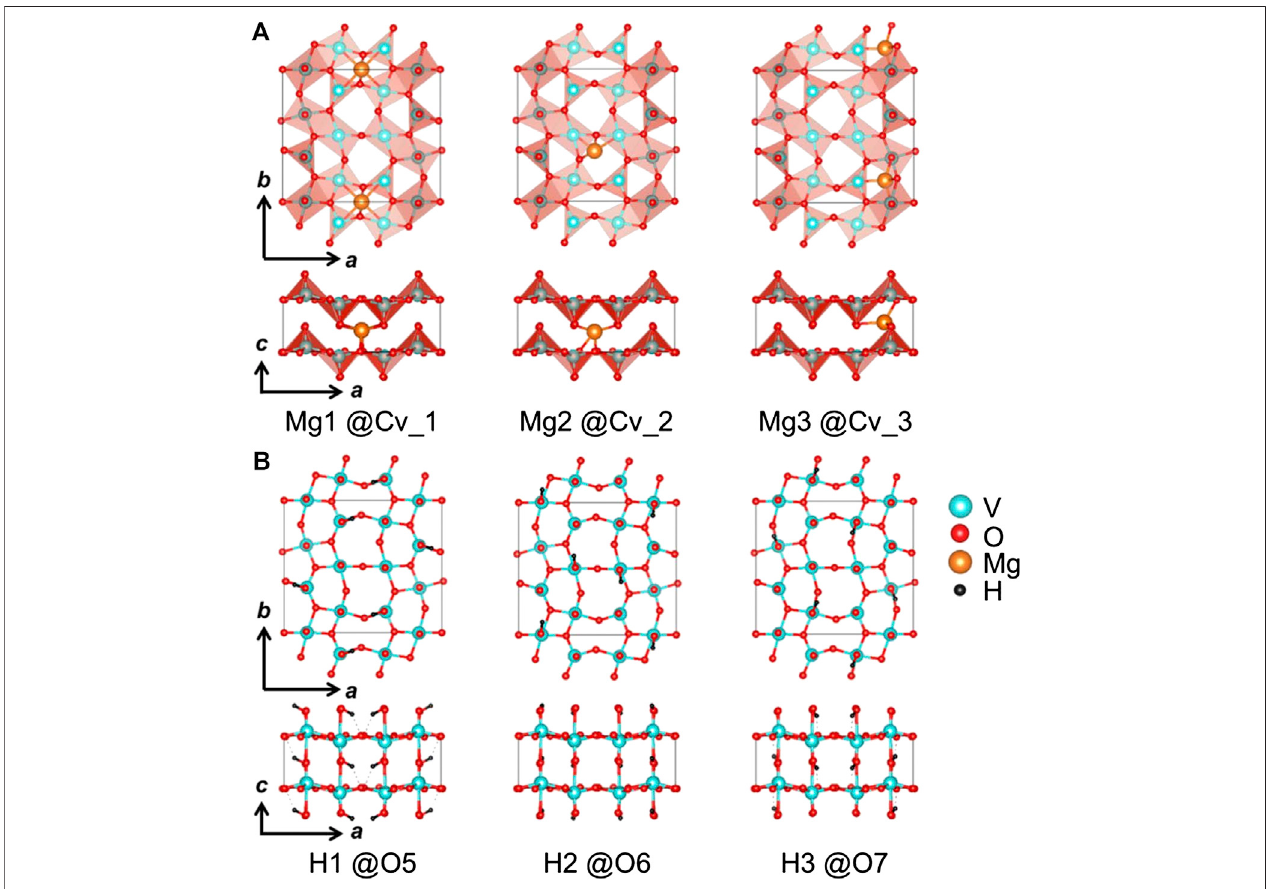
FIGURE 3 | Optimized positions of magnesium and proton ions suggested by DFT calculations for Mg 0.17 H x V 2 O 5 ( x (cid:2) 1): (A) Mg ions in three cavity sites (Cv_1, Cv_2, and Cv_3), and (B) protons around the three apical oxygen atoms ( 5 O, O6, and O7). Reprinted (adapted) with permission from Inorg. Chem. 2017, 56, 14, 7668 – 7678. Copyright 2017 American Chemical